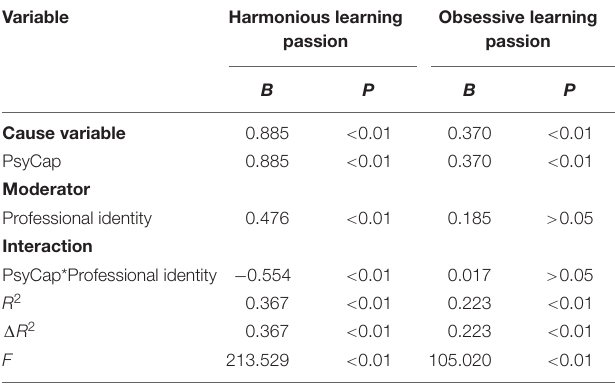
TABLE 4 | Moderated regression analysis ( N =